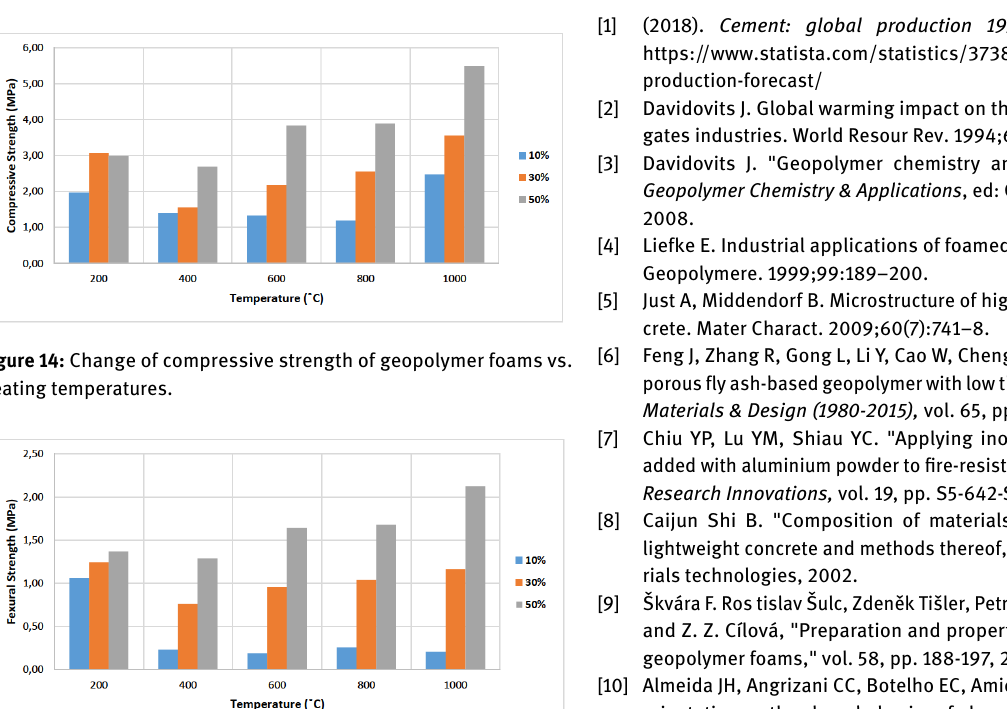
Figure 13: The density of geopolymer foams with different content of basalt waste fibre at high temperature.